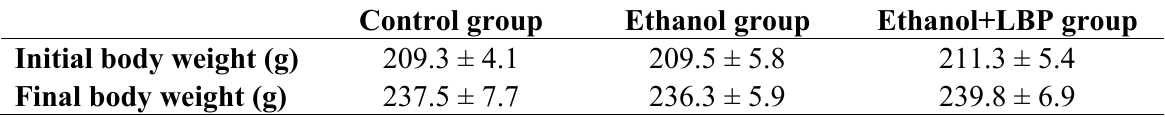
Table 1. Effect of LBP on body weights of rats in three groups.